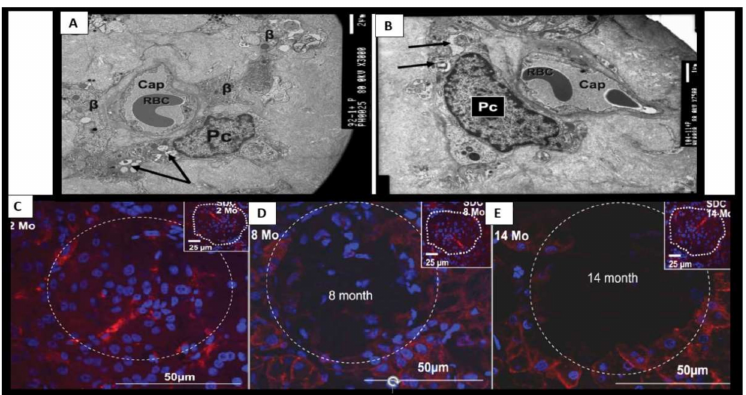
Figure 14. Pericyte apoptosis and loss within islets of 14-month-old HIP rat models. (Panels ( A , B )) depict sparse islet capillaries embedded within a sea of islet amyloid. Note pericyte(s) (Pc) apoptosis with apoptotic bodies (arrows). Endothelial apoptosis was not observed in these intra-islet regions in the HIP rat models in contrast to Pcs. (Panels ( C , D )) are confocal immunohistochemistry stains of the islets with antibodies to the platelet-derived growth factor receptor beta (PDGFR- β ) (red) and DAPI (blue) staining of islet cells. Note the progressive loss of intra-islet staining of pericytes (PDGFR- β red stain) and also note the progressive loss of cellularity (DAPI blue staining) within the islets from two months to 14 months in the HIP rat models. This suggests that, in addition to the loss of intra-islet cellularity, there is a loss of capillary pericytes. Thus, pericyte loss / apoptosis appears to play a significant role in the development of T2DM, at least in the HIP rat model of T2DM, similar to that found